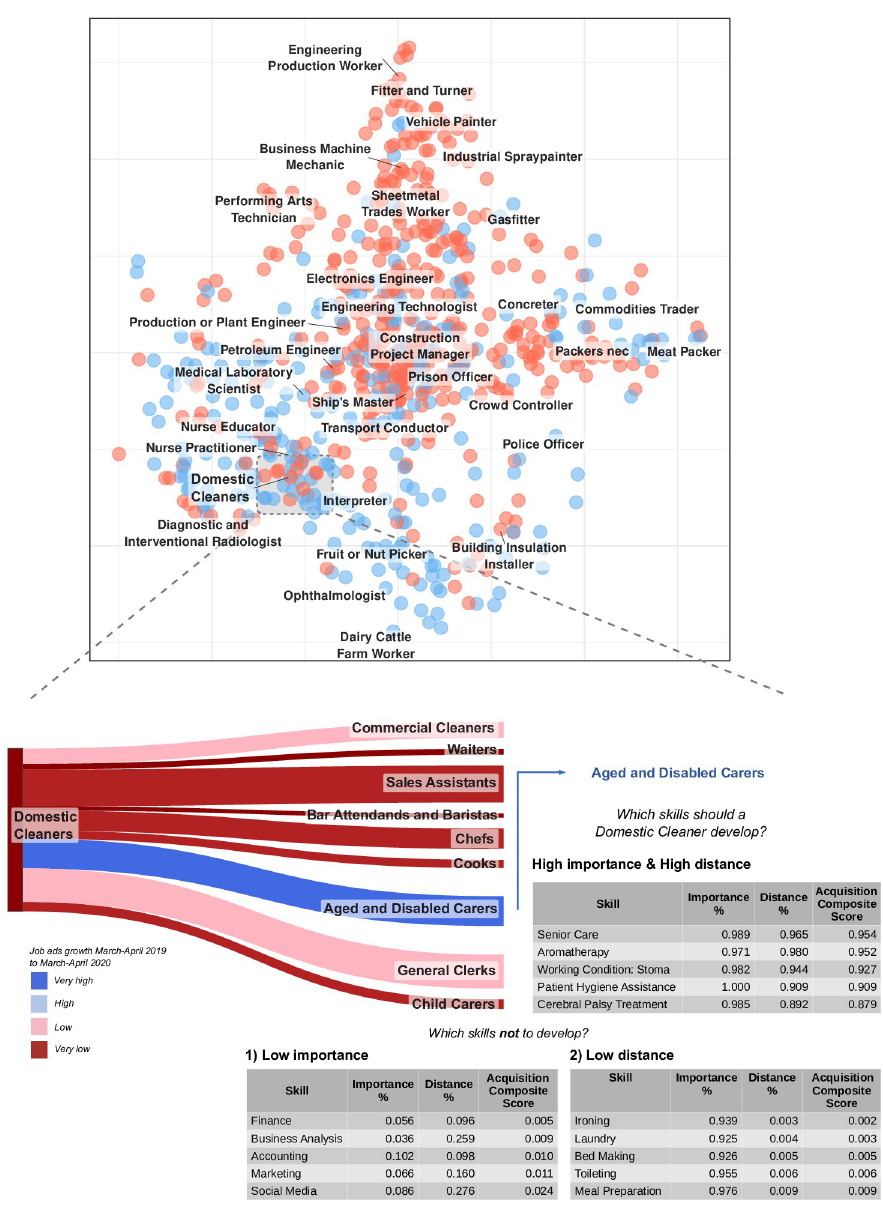
Fig 5. Here, we demonstrate the Job Transitions Recommender System using the ‘Domestic Cleaner’ occupation as an example—An occupation classified as a ‘non-essential’ occupation and that has experienced significant declines during the beginning of the COVID-19 outbreak in Australia. (upper panel) The two-dimensional space of occupations (see Fig 1) with ‘essential’ occupations in blue markers and ‘non-essential’ occupations in red markers. (lower panel) We first use the Transitions Map to calculate the occupations with the highest transition probabilities (other than itself). These are the nodes on the right side of the flow diagram in the bottom panel of the figure, where the link colors depict posting frequency percentage change from March-April 2019 to March-April 2020. The link widths represent the posting frequency volume of March-April 2020 to indicate labor demand. The top six occupations have all experienced significant declines during the COVID-19 period; however, the seventh recommendation, ‘Aged and Disabled Carers’, is experiencing significant labor demand growth. ‘Aged and Disabled Carers’ were also classified as an ‘essential’ occupation during COVID-19 in Australia. We select this as the target occupation and then make personalized skill recommendations. We argue that workers trying to transition to another occupation should invest time and resources into skill development when (1) the skills are of high importance and (2) there is a high distance to acquire the skill. Conversely, workers should not focus on skill development if (1) the skills are low importance or (2) there is a low distance to acquire the